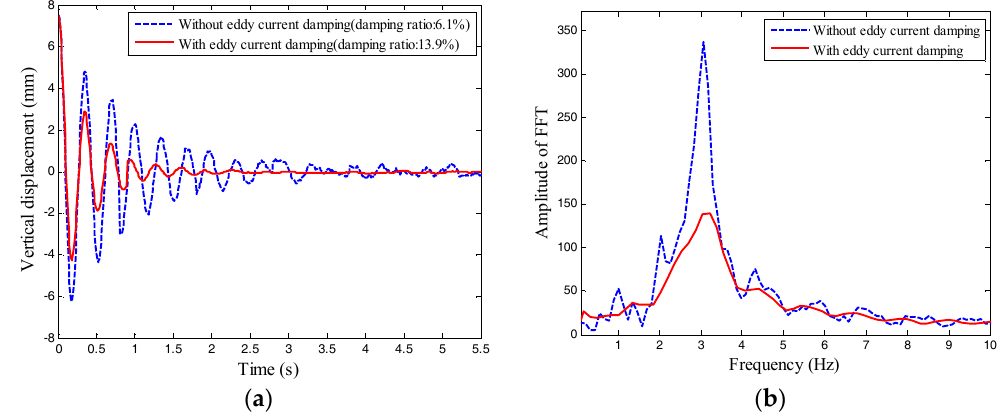
Figure 10. Vertical free vibration history and its response in frequency domain of the ECTMD with and without eddy current damping in seawater: ( a ) free vibration; ( b ) FFT amplitude.